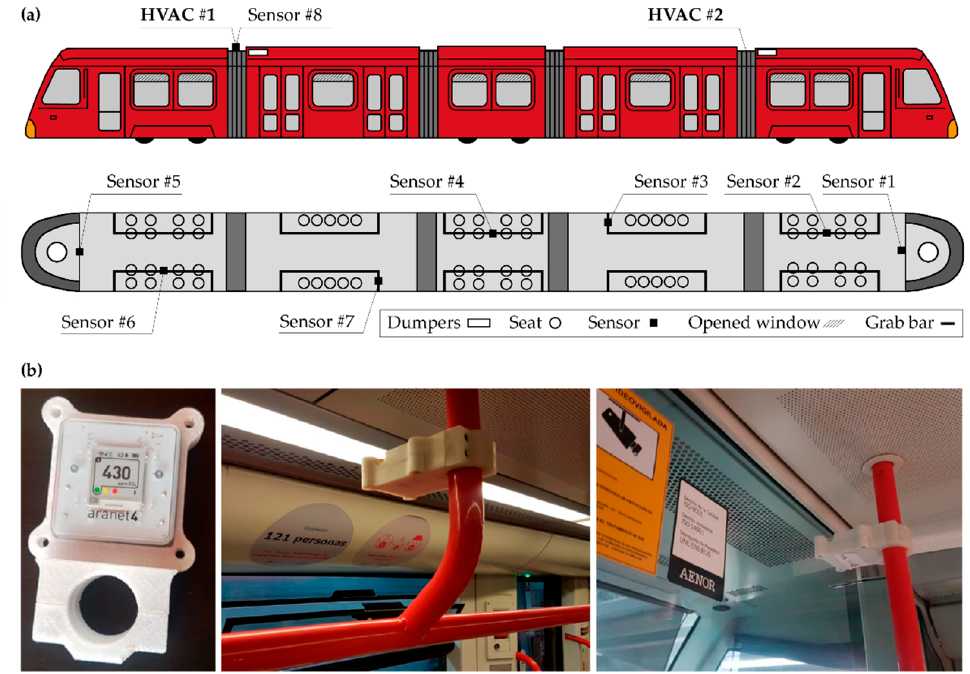
Figure 1. Schematic representation ( a ) of the meters distribution in the Tram and ( b ) installed sensors in the Tram. Where, # refers to the meter ID.